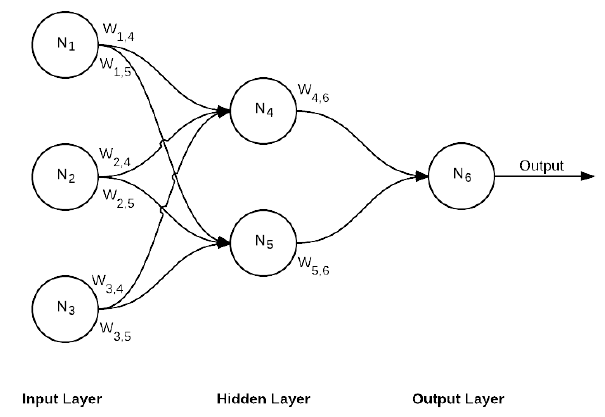
Figure 6. Fully connected layer.